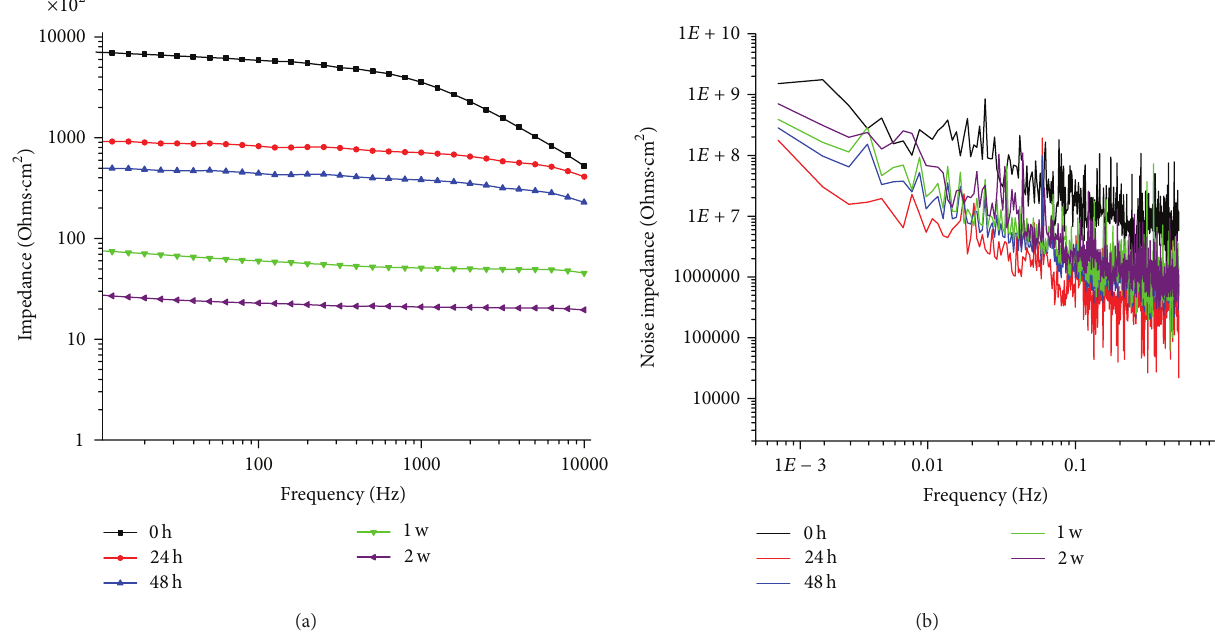
Figure 8: ABS-3 copper coupons in Na 2 SO 4 + 3wt% NaCl solution in time: (a) Bode impedance diagrams and, (b) electrochemical resistance noise.